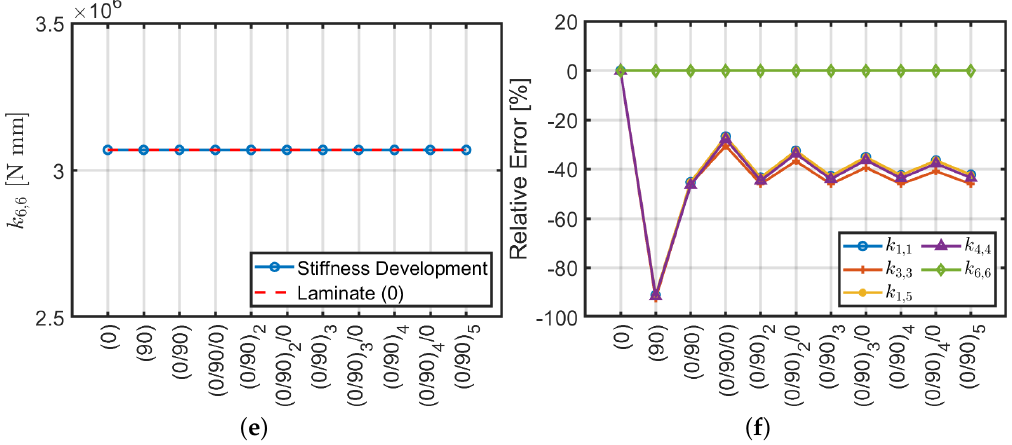
Figure 2. Stiffness trends with respect to the number of plies ( a – e ) and relative error with respect to an orthotropic configuration ( f ).